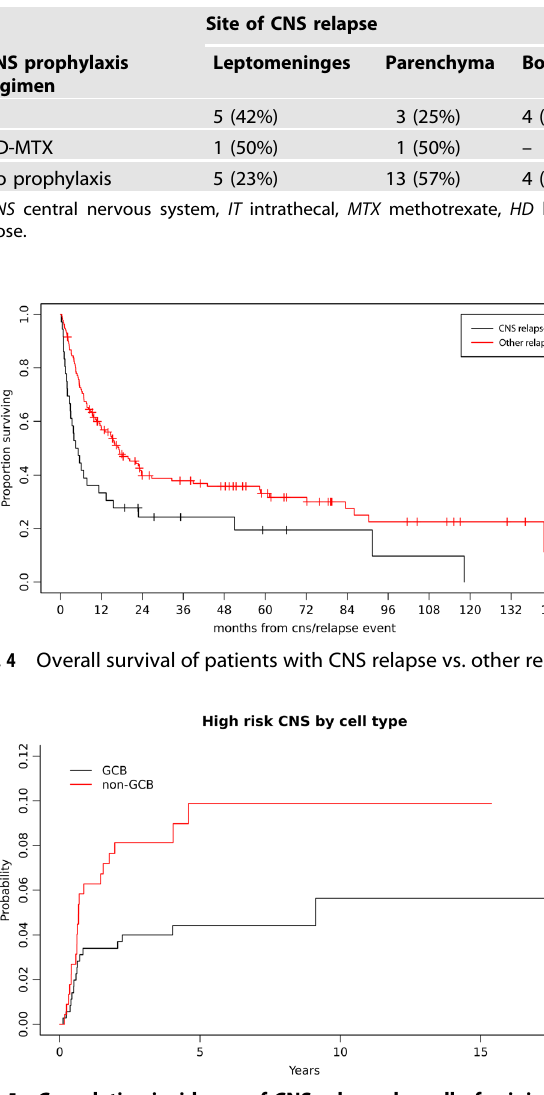
Fig. 5 Cumulative incidence of CNS relapse by cell of origin. GCB germinal center B-cell phenotype, non-GCB non germinal center B- cell